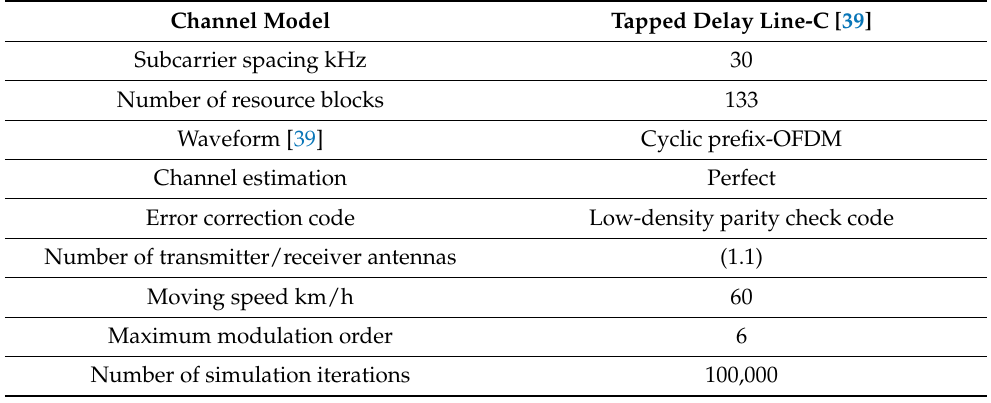
Table 1. Configurations of wireless transmission based on 5G.